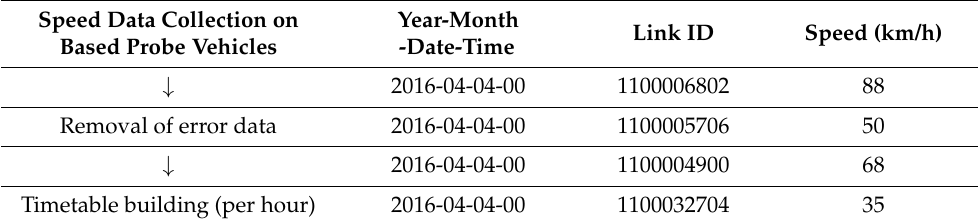
Table 5. Operating speed data conversion and corresponding form. Speed Data Collection